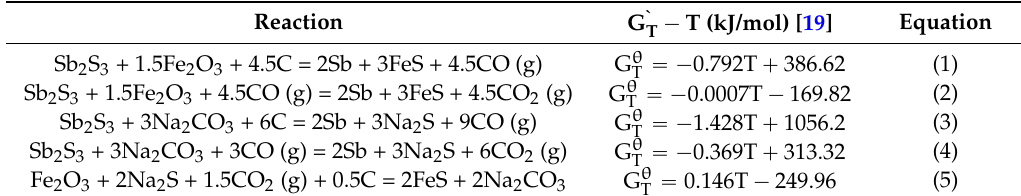
Table 2. Main reactions occurred during reductive sulfur ‐ fixing smelting of stibnite concentrate. Reaction